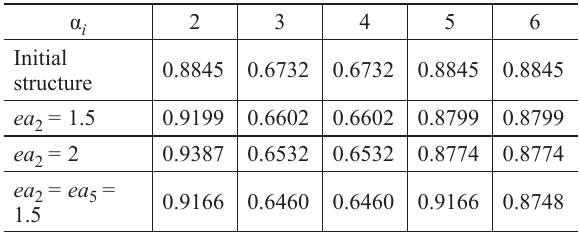
Fig. 3. Planar truss structures with different bar stiffness Table 4. Results of planar trusses with different bar stiffness as in Figure 3